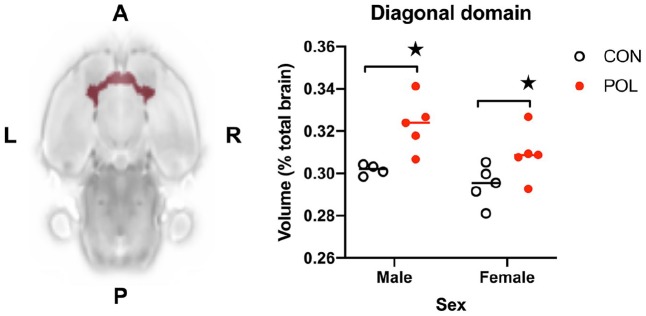
Prenatal exposure to POL at GD15 resulted in a significant main effect of MIA on the relative volume of the diagonal domain (DD) with an increase in POL-exposed offspring compared to controls at PD21. Data shown are relative volumes, expressed as the percentage of total brain volume.★p < 0.01 main effect of MIA. A, Anterior; P, posterior; L, left; R, right.